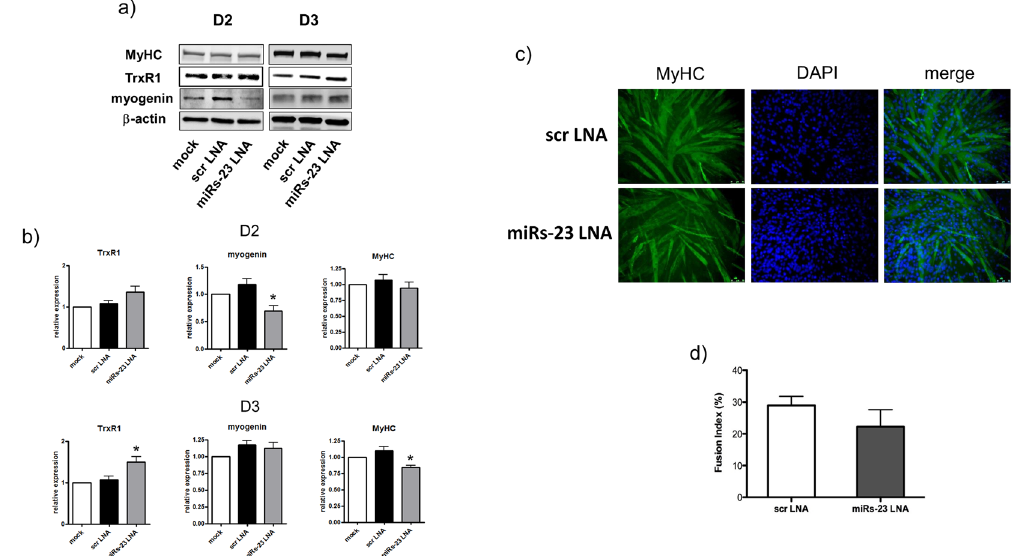
Figure 6. miRs-23 LNA transfection negatively affects Myogenin and MyHC expression and counteracts the downregulation of TrxR1 during C2C12 differentiation. C2C12 were transfected or not (mock) with miRs-23 LNA or a scramble LNA (scr LNA) and analysed at 48 (D2) and 72 hours (D3) from differentiation induction. ( a ) Representative image of the western blot analysis showing the protein expression of TrxR1, MyHC, Myogenin and β -actin. ( b ) The amount of TrxR1, MyHC and Myogenin in each sample was calculated by normalizing to β -actin protein levels. Results are represented as mean ± SEM of at least three different experiments. The ratio of mock sample was set = 1. ( c ) Representative image (20x magnification) of the immunofluorescence analysis showing MyHC expression at D3 of differentiation and the related fusion index ( d ). DAPI staining was used to detect